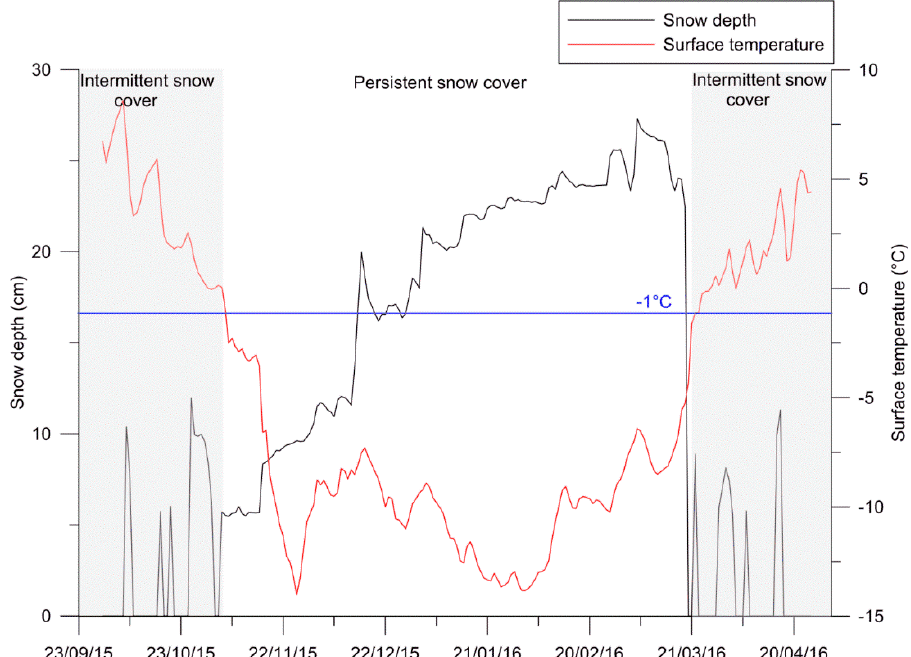
Figure 4. An example of the discrimination of intermittent and persistent snow cover, determined from the combination of albedo and air temperature measurements. The red and blue lines indicate the observed daily mean surface temperature and the threshold of − 1 °C, respectively. The black line describes the typical snow accumulation during the snow season.